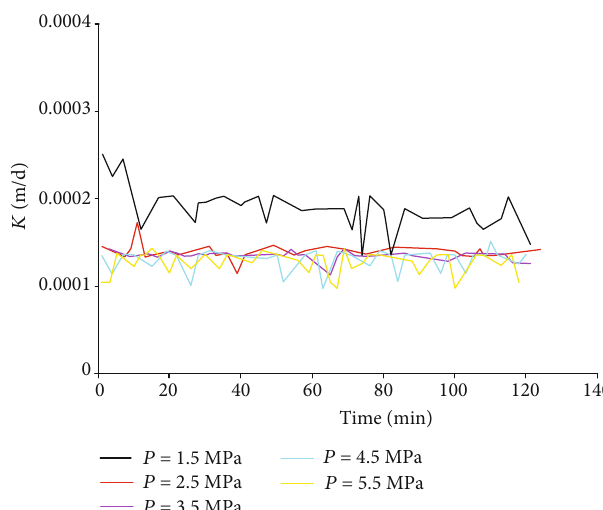
Figure 5: The variation curves of hydraulic conductivity of the preliminary seepage experiments.